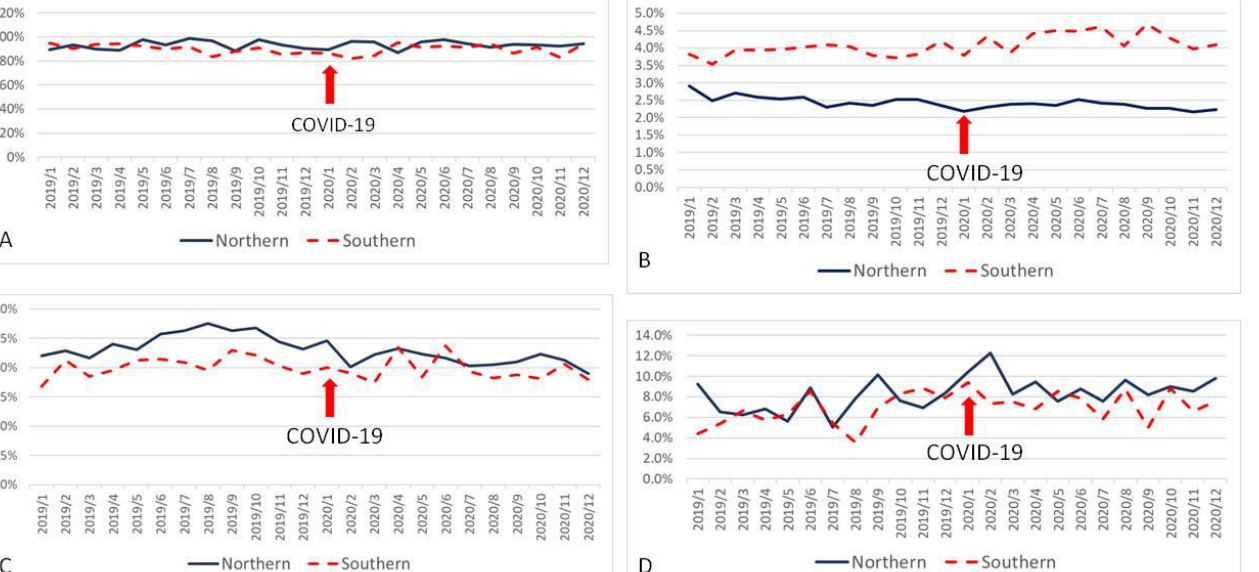
Figure 2. Control chart of hospitalization-related quality indicators based on the location of medical centers (red arrow represents outbreak of COVID-19). ( A ): In-hospital mortality rate excluding crit- ical discharge against medical advice. ( B ): Unscheduled returns within 14 days for the hospitalized patients.